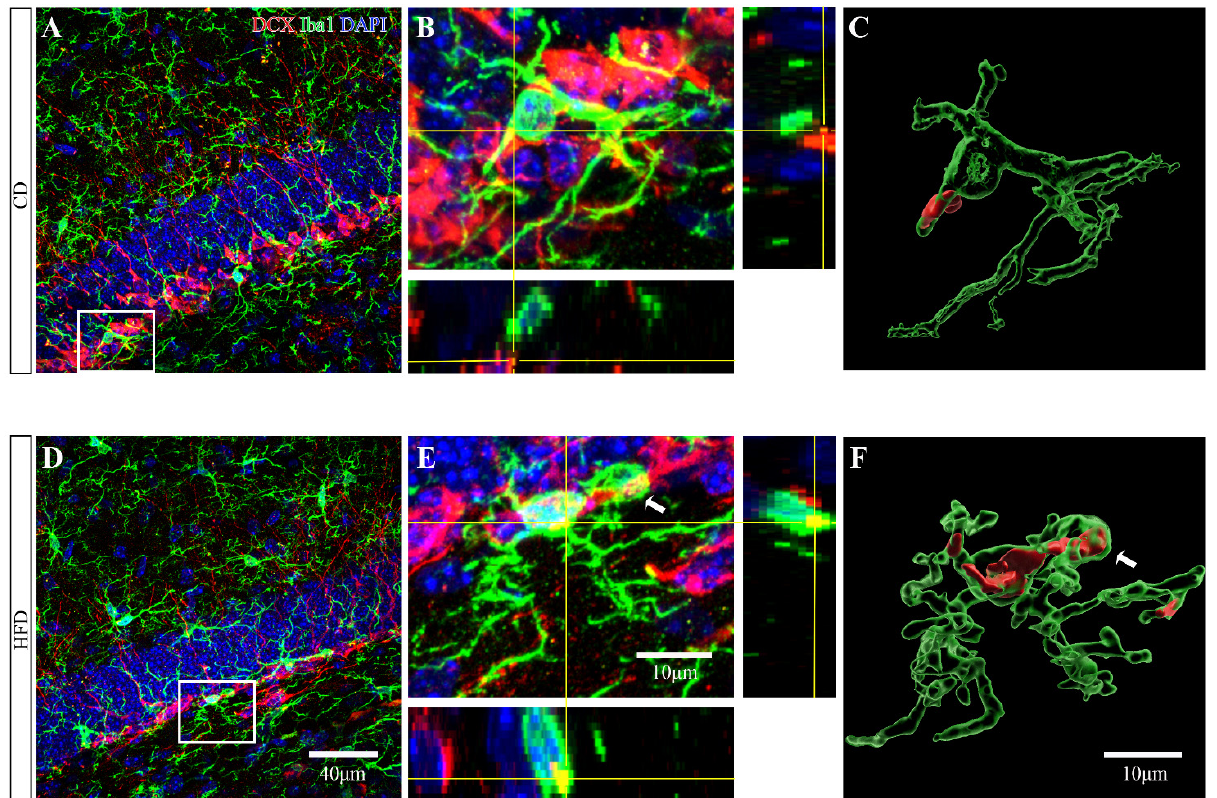
Figure 7. Effect of HFD consumption in adolescence on microglial phagocytosis of newborn neurons in the mouse ventral hippocampus. ( A , D ) High-resolution confocal images of Iba1 + and DCX + cells in the ventral hippocampus of CD- and HFD-fed mice. Red, green, and blue fluorescence represent DCX, Iba1, and DAPI, respectively. ( B , E ) An orthogonal view of a confocal image showing the expression of DCX (red) within microglia (green). ( C , F ) Three-dimensional reconstruction and surface renderings were prepared using Imaris software (green and red surface renderings represent microglia and DCX staining inside). The white arrowheads indicate phagocytic cups of microglia.